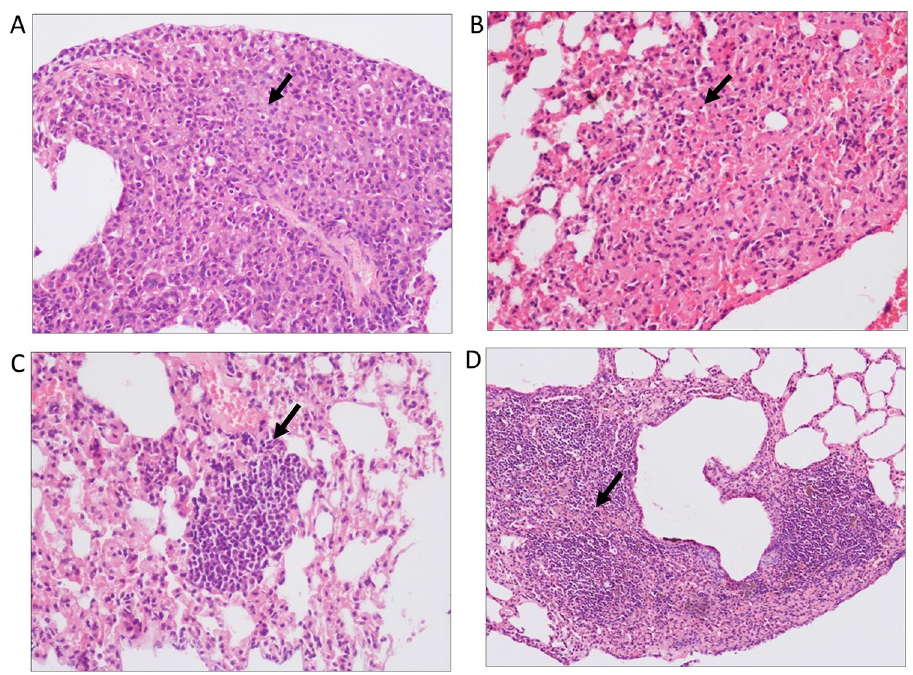
Figure 6. Histological examination of lung morphology to assess the presence of granulomas in untreated and treated groups. Hematoxylin & Eosin staining was performed on lung tissue sections of untreated and INH + RIF treated latent tuberculosis and latent tuberculosis with diabetes group. Lung section of ( A ) Group-Ia animals ( B ) Group-Ib animals ( C ) Group-IIa animals ( D ) Group-IIb animals after 4 weeks of treatment. Arrows indicate granulomas in lung sections ( A , B , D ) and inflammation ( C ). Images were taken at 20× magnification Group-Ia: latent tuberculosis untreated, Group-Ib: latent tuberculosis treated with INH + RIF, Group-IIa: latent tuberculosis with diabetes untreated, Group-IIb: latent tuberculosis with diabetes treated with INH +